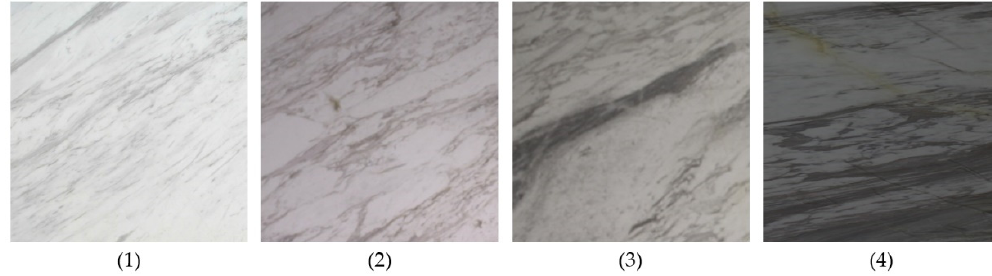
Figure 2. Examples of different marble background types.